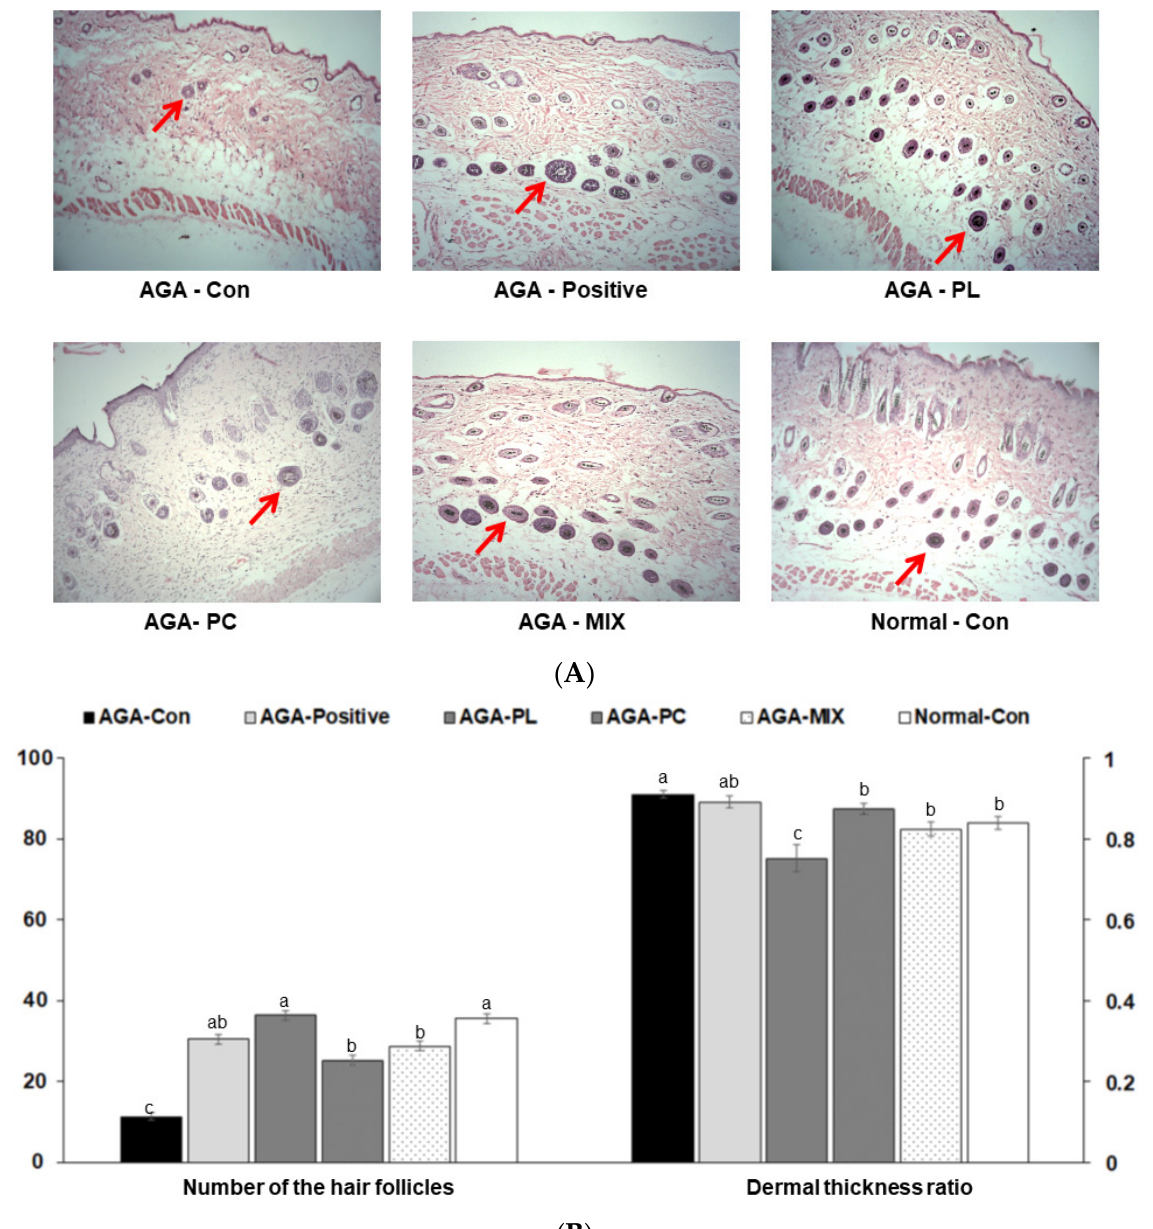
Figure 4. Histological differences and hair follicle densities in dorsal skins. ( A ) Histology of H&E-stained dorsal skins. ( B ) The red arrows indicate the hair follicle. AGA was induced with the application of 0.5% testosterone propionate solution on the back of mice, and AGA-induced mice orally consumed 0.1% PL, 0.1% PC, or 0.1% mixture of PL and PC (1:1, w / w ) in a 43% fat diet (HFD), called AGA-PL, AGA-PC, or AGA-MIX groups, respectively. AGA-induced mice were daily applied with 2% finasteride on the back, as AGA-Positive (positive control). AGA-Positive and AGA-Con (control) mice had 0.1% cellulose (no effective activity in AGA treatment) in HFD. Normal-Con did not induce AGA and consumed 0.1% cellulose in HFD. All mice had an 8-week treatment. After 28 days of treatment, dorsal skins were fixed with 10% formaldehyde, embedded in paraffin, sectioned, and stained with hematoxylin and eosin. Original magnification 100 × . Bars and error bars are mean ± standard deviations (N = 11 or 12). a,b,c Different letters on the bars indicate a significant difference as per a Tukey test at p < 0.05, and no or the same letters indicate no significance between the groups.